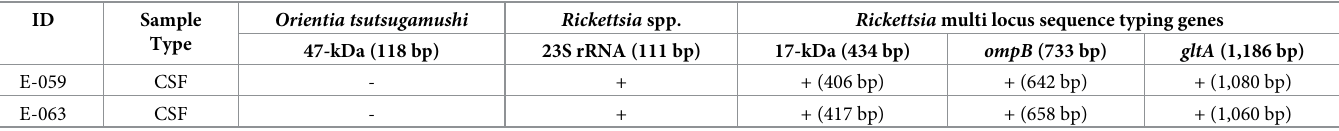
Table 1. Summary of molecular result of suspected Rickettsia